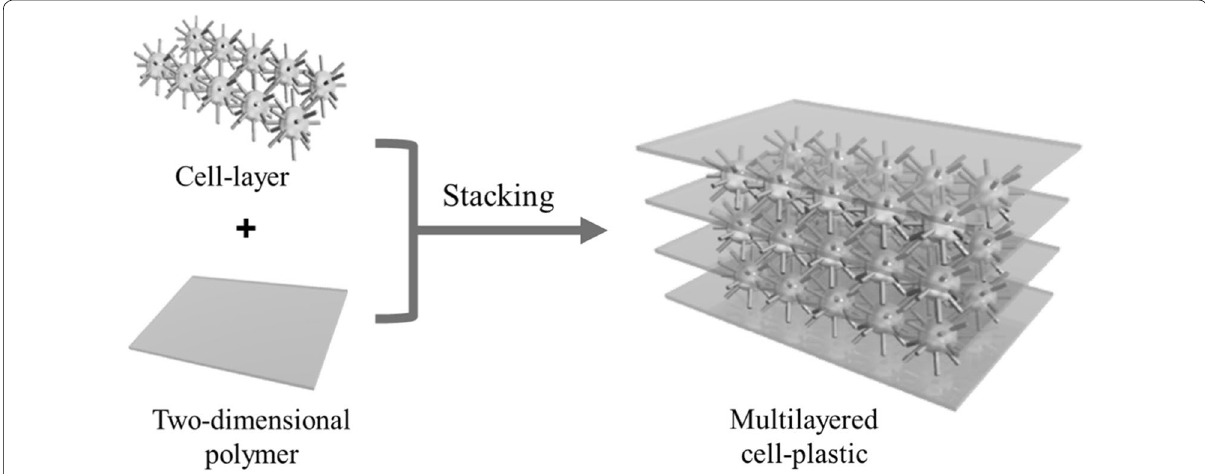
Fig. 1 Schematic model of the concept of this